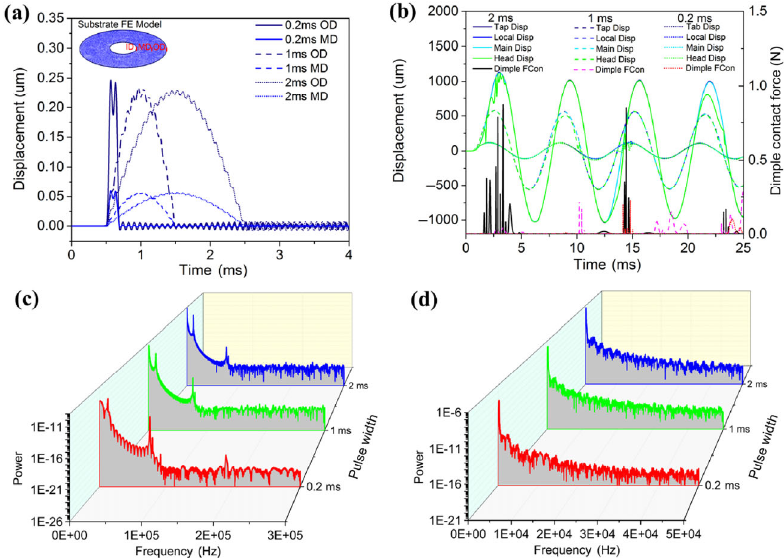
Fig. 6 Shock response of the substrate and suspension-PFH system without the air bearing effect under different pulse widths: (a) substrate response at the outer diameter (OD) and middle diameter (MD), (b) response of different components of the PFH system and dimple–head contact force (Dimple FCon), (c) power spectra of the substrate, and (d) power spectra of the